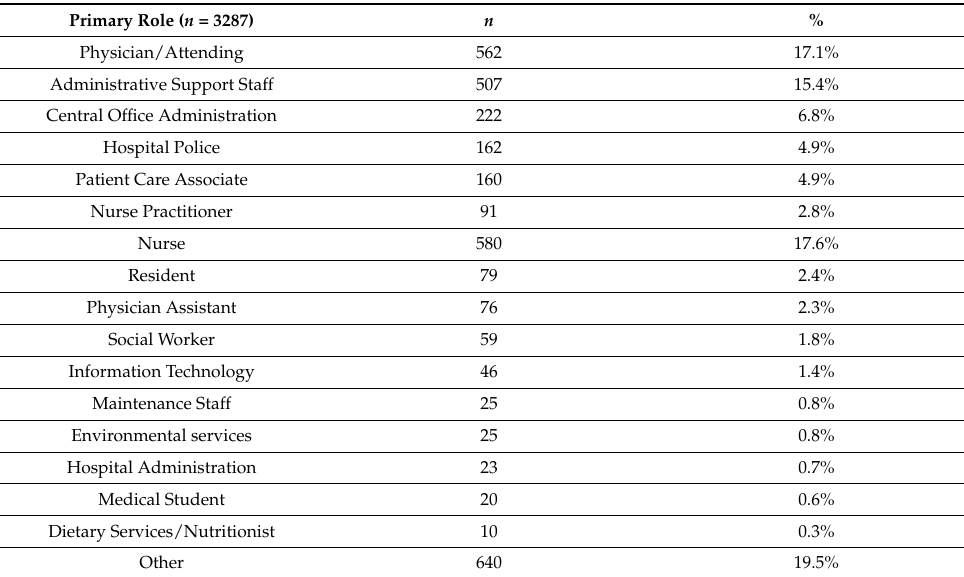
Table 2. Primary role in the health care